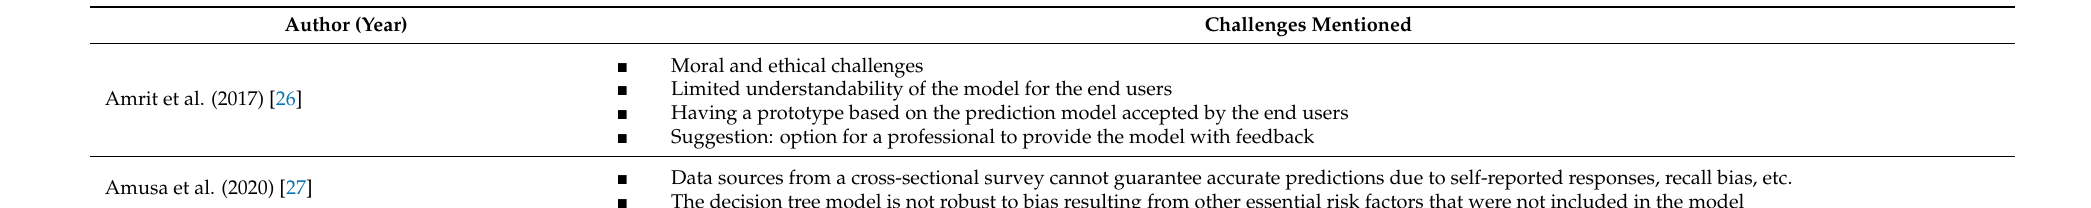
Table 3. Challenges in implementing machine learning in domestic